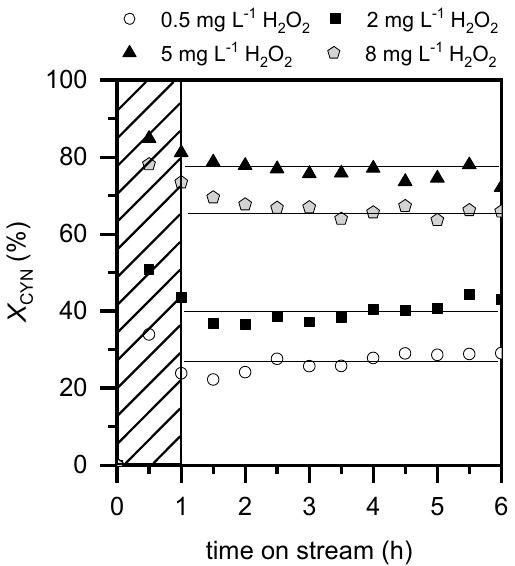
Figure 4. Effect of H 2 O 2 dose on the removal of CYN upon CWPO (flow rate = 0.2 mL min − 1 , [CYN] 0 =